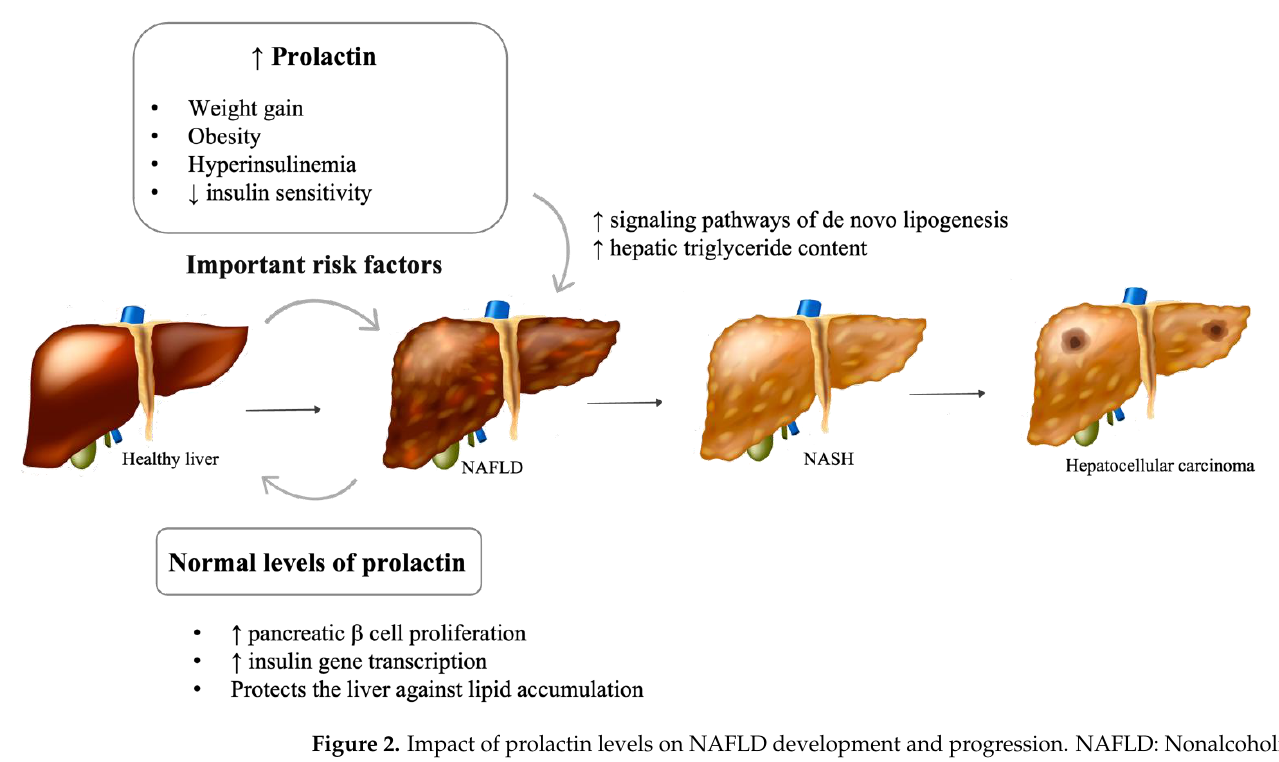
Figure 2. Impact of prolactin levels on NAFLD development and progression. NAFLD: Nonalcoholic fatty liver disease; NASH: Nonalcoholic steatohepatitis; GH: Growth hormone; IGF1: Insulin-like growth factor 1. [Viktoriia Kasyanyuk] © 123RF.com (accessed on 22 February 2022) and Servier Medical Art by Servier.